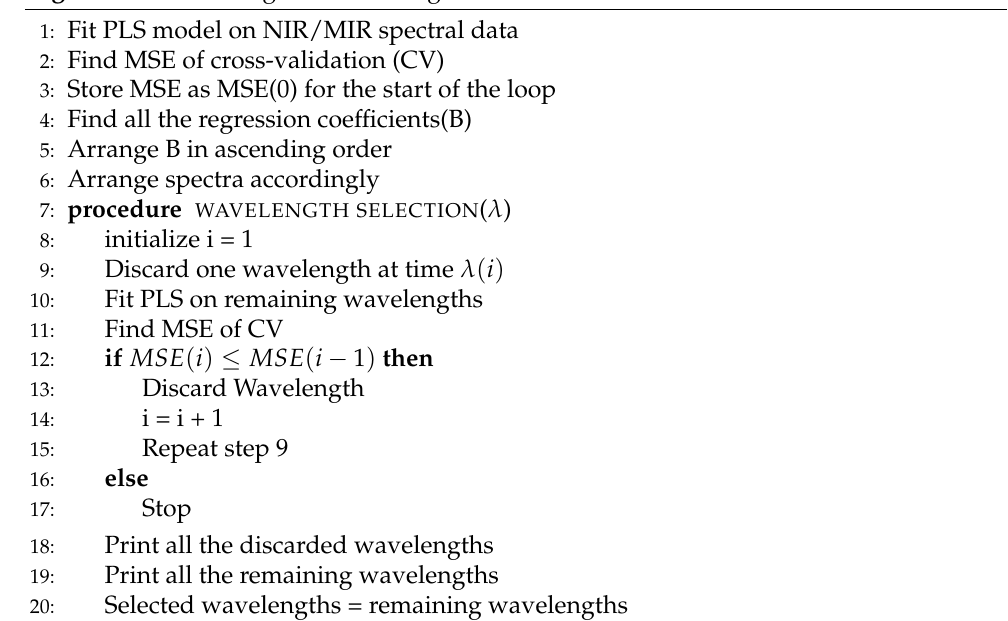
Algorithm 1 Wavelength selection algorithm